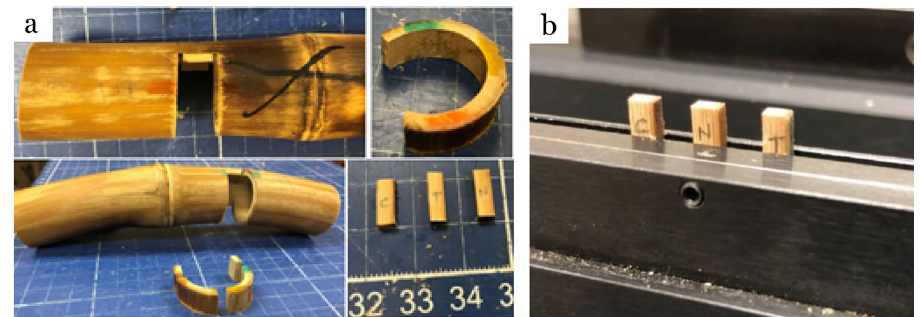
Figure 2. Sample preparation and testing: ( a ) sampling steps from bending bamboo section, ( b ) holding of samples during